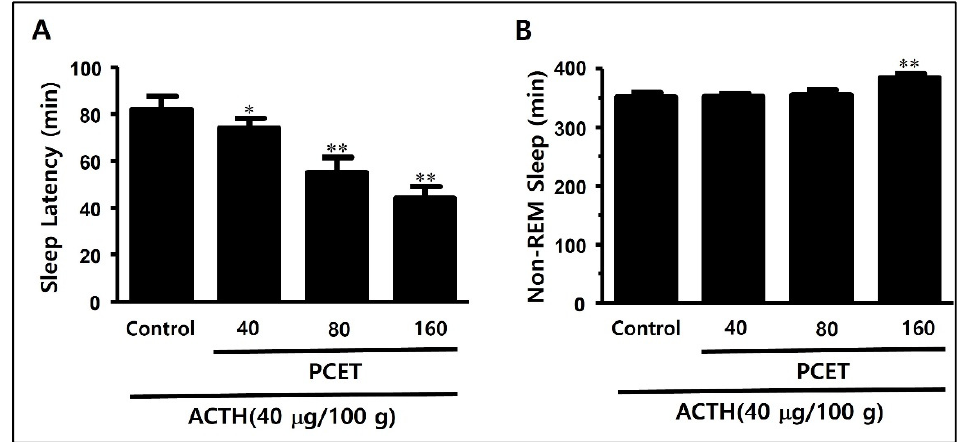
Figure 9. PCET effect on improving sleep disorders by subcutaneous ACTH injection. The subcuta- neous injections of ACTH (400 μ g/kg) in SD rats on days 1, 5, and 10, followed by oral gavage of PCET (40, 80, 160 mg/kg), resulted in ( A ) a significant concentration-dependent decrease in sleep latency, and ( B ) a significant increase in non-REM sleep time at maximum dosage (160 mg/kg). The data are shown as mean ± standard deviation. Each group consists of three rats. The statistical significance was evaluated based on the p -value, and * p < 0.01 and ** p < 0.001 indicate significant differences from the control.